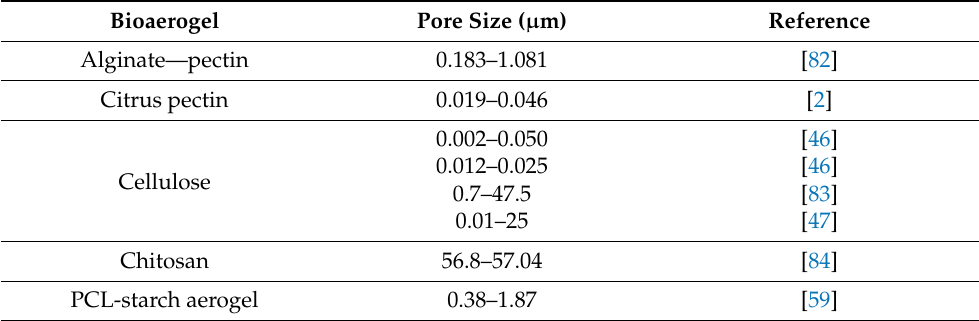
Table 3. Reported pore size or macropore size distribution of some bioaerogels, obtained by mer- cury